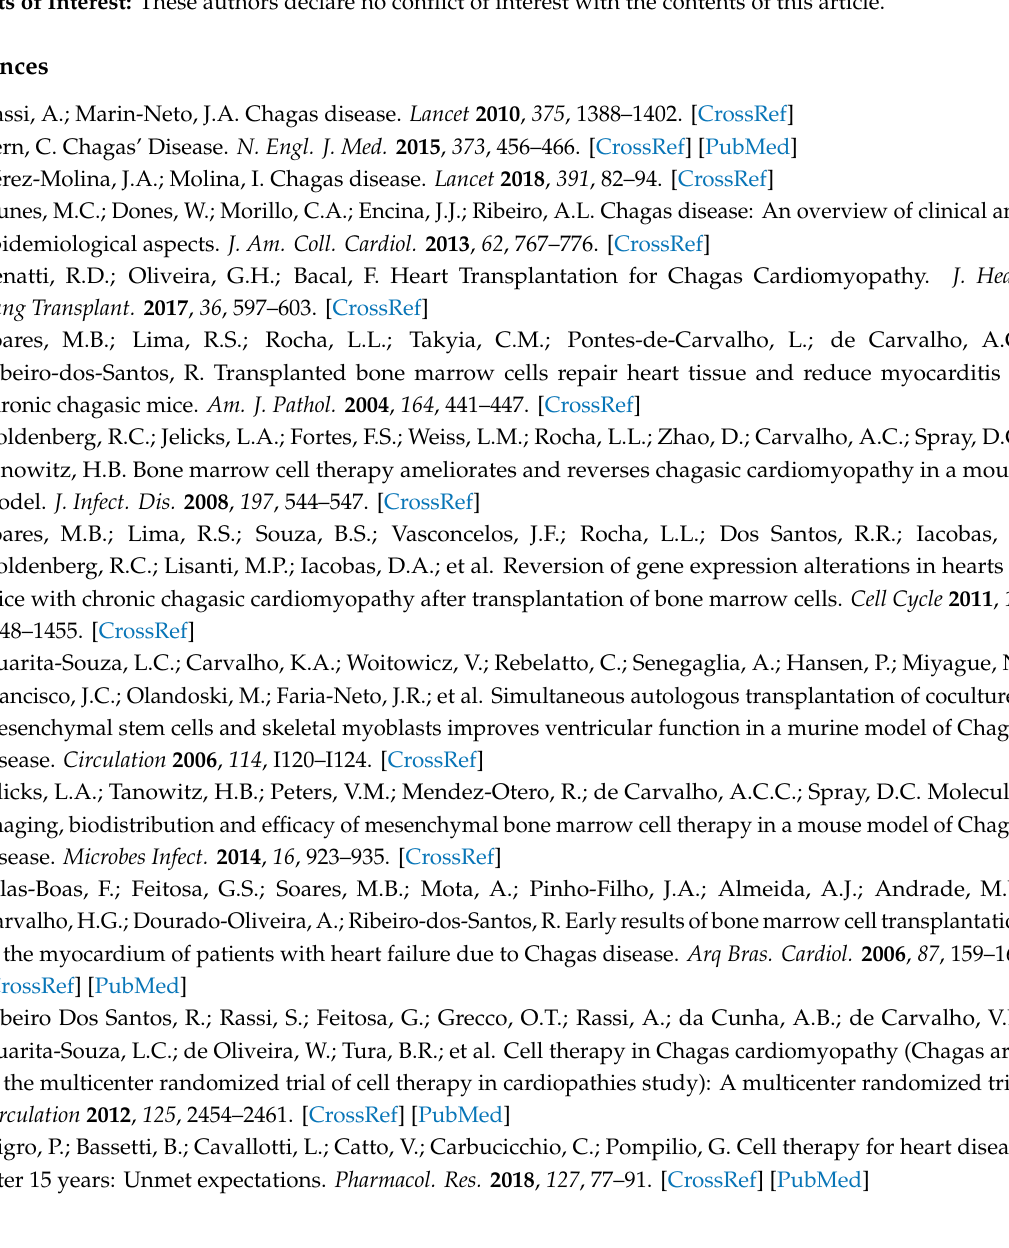
Figure S1: Characterization and di ff erentiation of mESC. Table S1: Primers sequences for mESC pluripotency gene